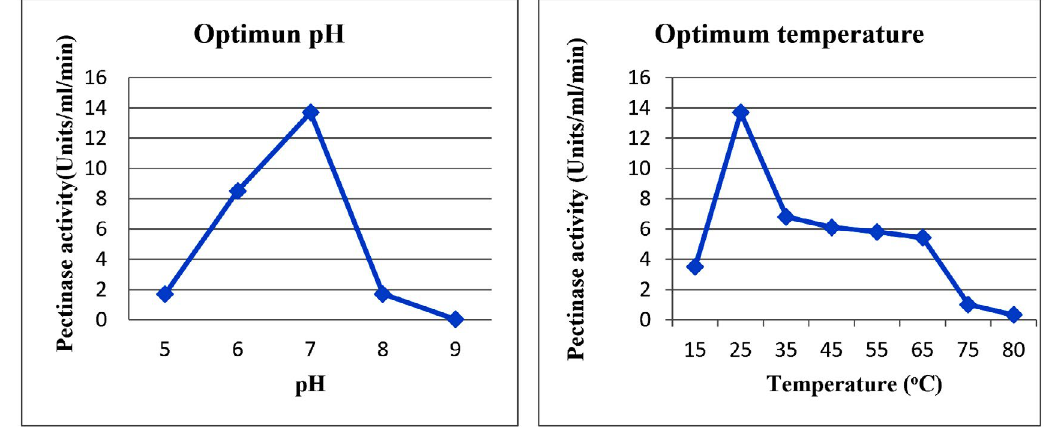
Fig. 5 . Optimum temperature (a) and pH (b) of pectinase from Meyerozyma sp. VITPCT75